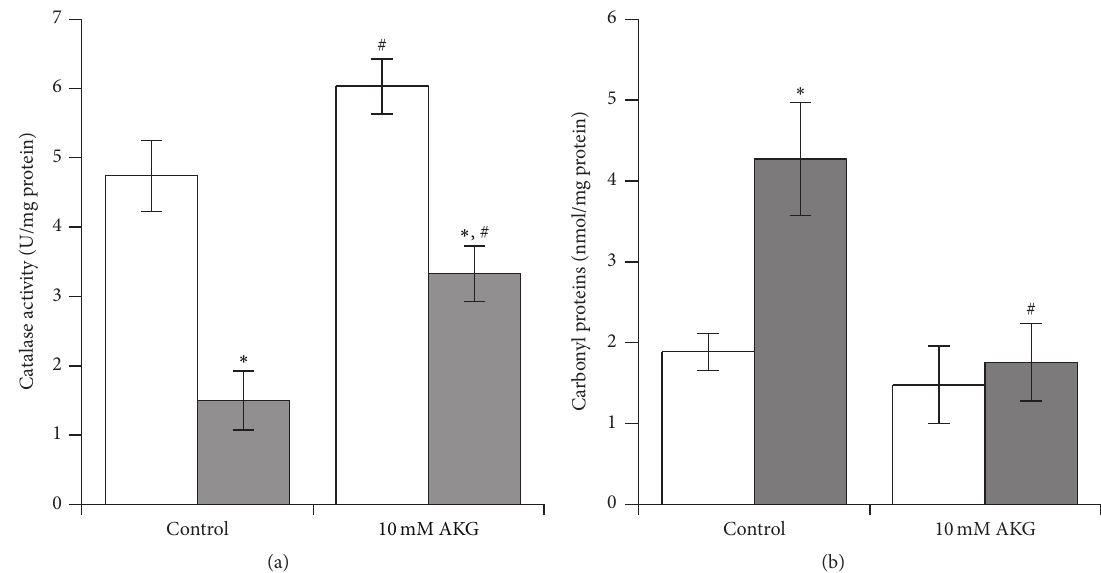
Figure 3: Effect of exposure to 10mM H 2 O 2 for 30 min on catalase activity (a) and level of protein carbonyls (b) in S. cerevisiae YPH250 cells grown in the absence or presence of 10mM AKG. Untreated cells (without H 2 O 2 ) and cells treated with 10mM H 2 O 2 are marked by white square and grey square bars, respectively. Data are means ± SEM, 𝑛 = 5 - 6 . ∗ Significantly different from respective values of untreated cells and # from respective values of control group (without AKG) with 𝑃 < 0.05 using Student’s t -test, 𝑛 = 5 - 6 .